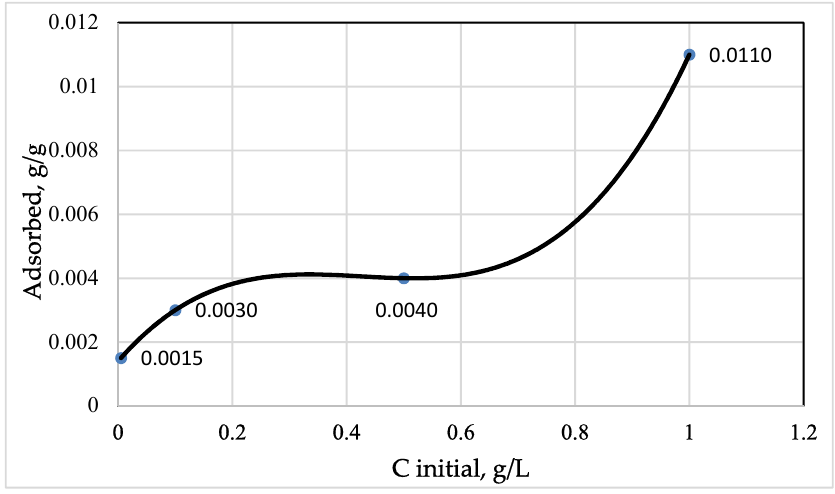
Figure 1. Isotherm of FA adsorption on bentonite.